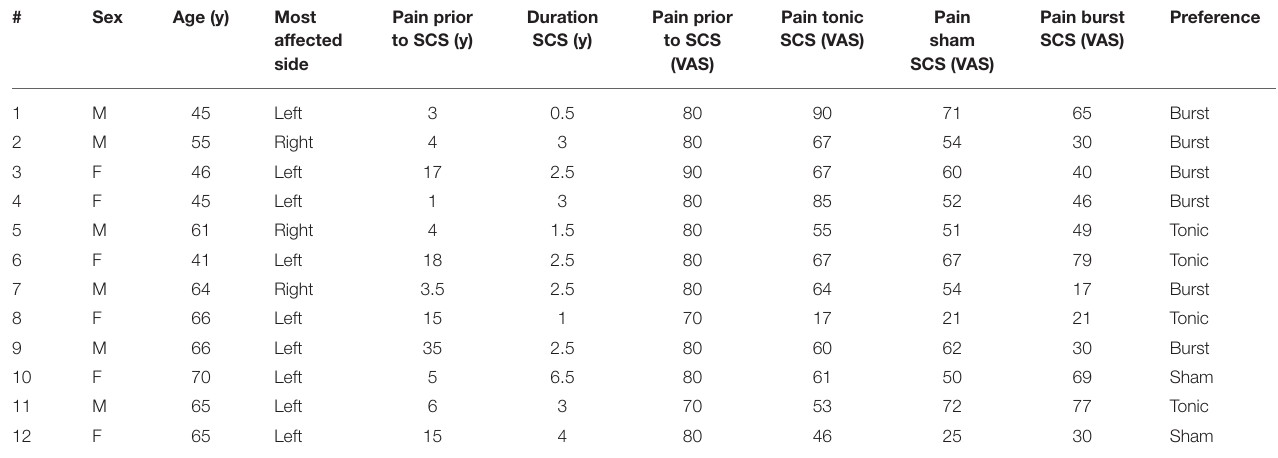
TABLE 1 | Participants’ demographics and their responses to the three different spinal cord stimulation (SCS) regimes: tonic SCS, sham SCS, and burst SCS.